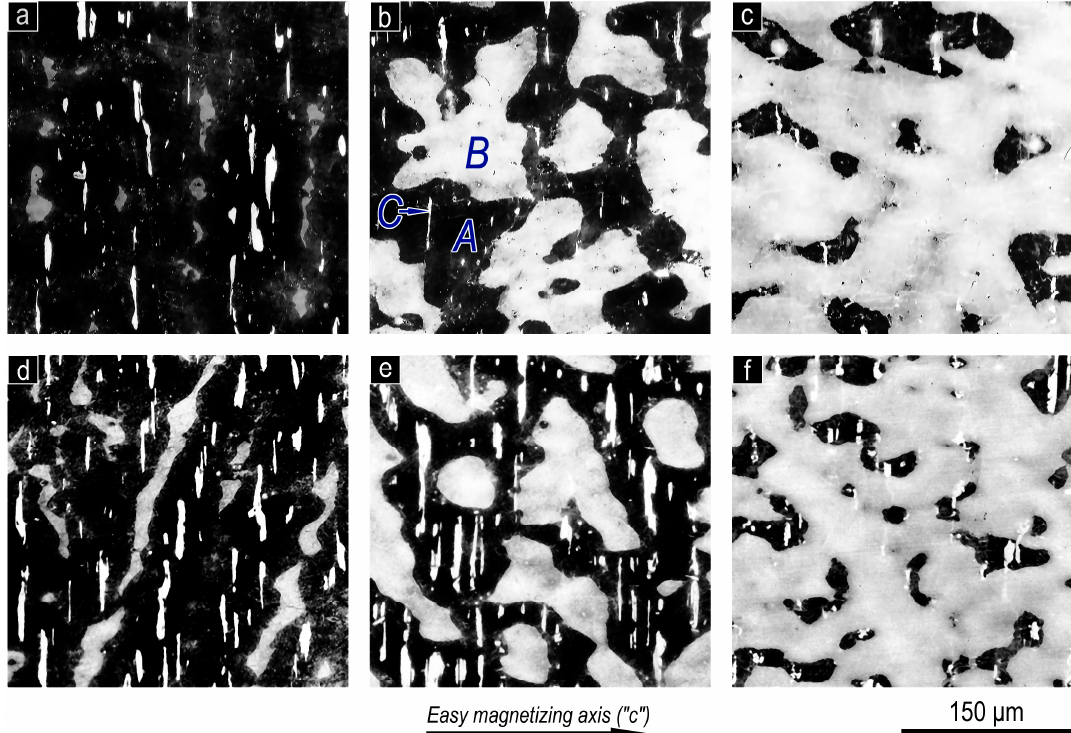
Figure 1. Microstructure on the prismatic plane of pseudo-single-crystal Sm 1-X Zr X (Co 0.702 Cu 0.088 Fe 0.210 )z samples after complete cycle of heat-treatments for the high-coercivity state, where ( a – c ) x = 0.15 at z = ( a ) 6.0, ( b ) 6.5, and ( c ) 6.8 and ( d – f ) x = 0.19 at z = ( d ) 6.0, ( e ) 6.3, and ( f ) 6.7 (optical microscope, etching in 5% alcohol solution of HNO 3 ). The easy magnetization axis is in the image plane and is strictly